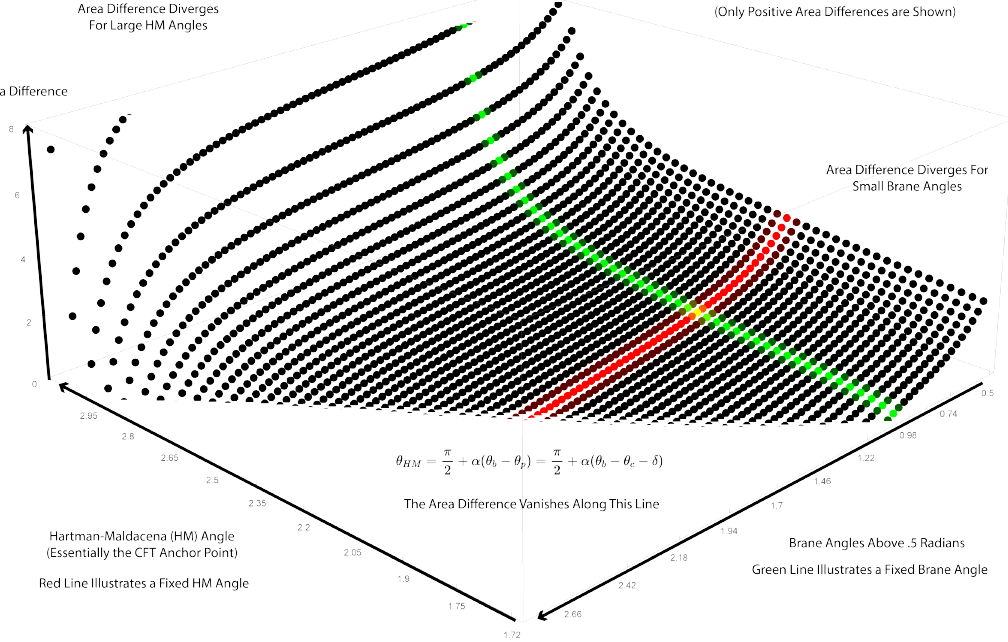
Figure 9 . Here we present the positive area difference as a function of θ b and θ HM . The parameter subspace for which the area difference vanishes is an approximately straight line. Negative brane tensions are most likely not physical but they have been included without much trouble. This figure is more complete than figures 6 and 7, which simply correspond to slices along the x and y axes, with the main difference being that Γ has been swapped out for θ . Note the area difference HM increases monotonically with θ and decreases monotonically with θ , and that the area difference HM b vanishes along an approximately straight